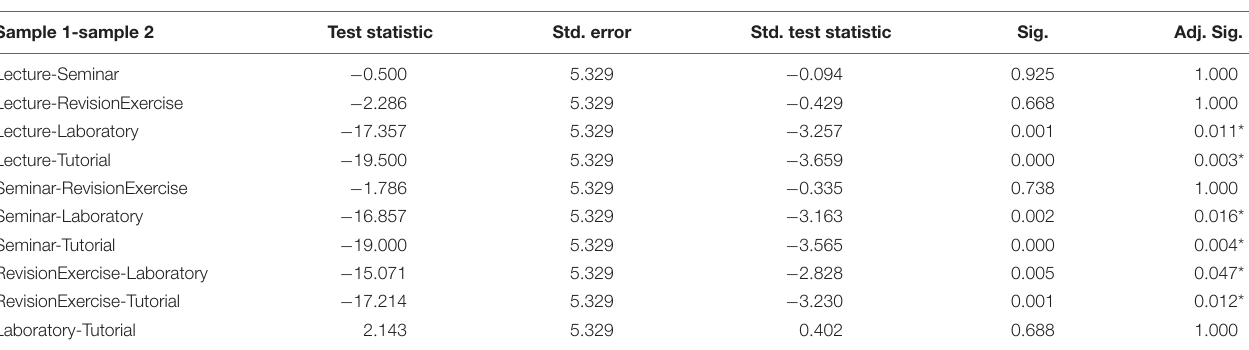
TABLE 6C | Post hoc pairwise comparisons for Hypothesis